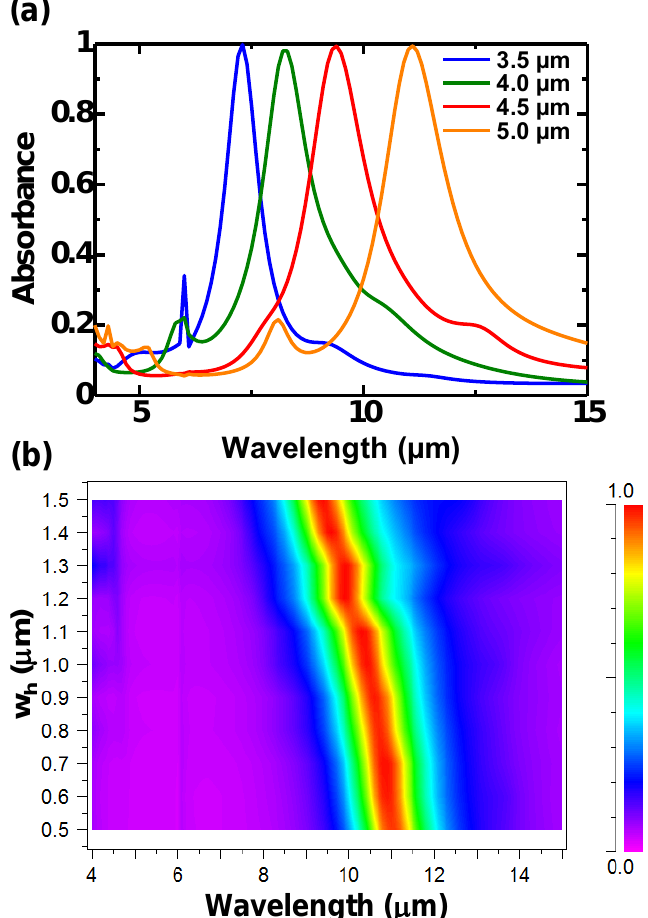
Figure 2. Calculated absorbance as a function of wavelength for various ( a ) micropatch widths ( w m ) and ( b ) inner diameters of tube-shaped posts ( w h ). In panel ( a ) w h is fixed at 1.3 µ m and in panel ( b ) w m is fixed at 4.5 µ m. The color-map defines the absorbance scale.